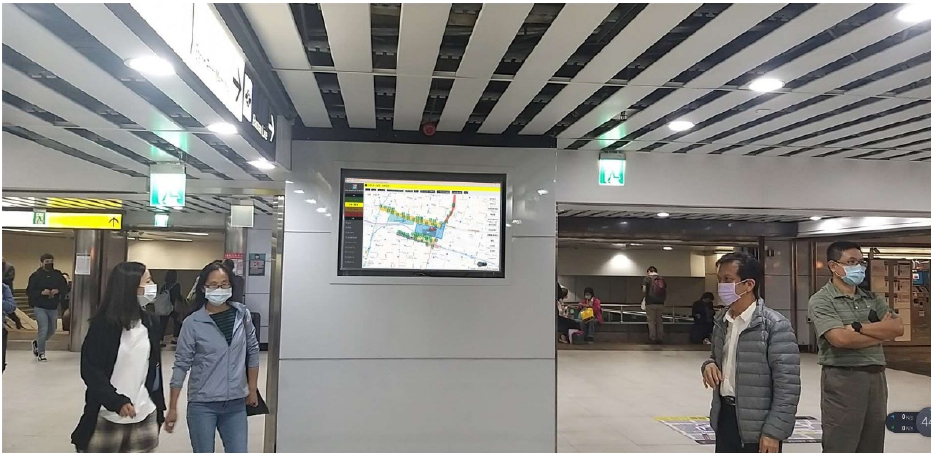
Figure 17. Television display at normal times. (Source: Taipei Main Station Intelligent Joint Disaster Prevention Center, 2021).